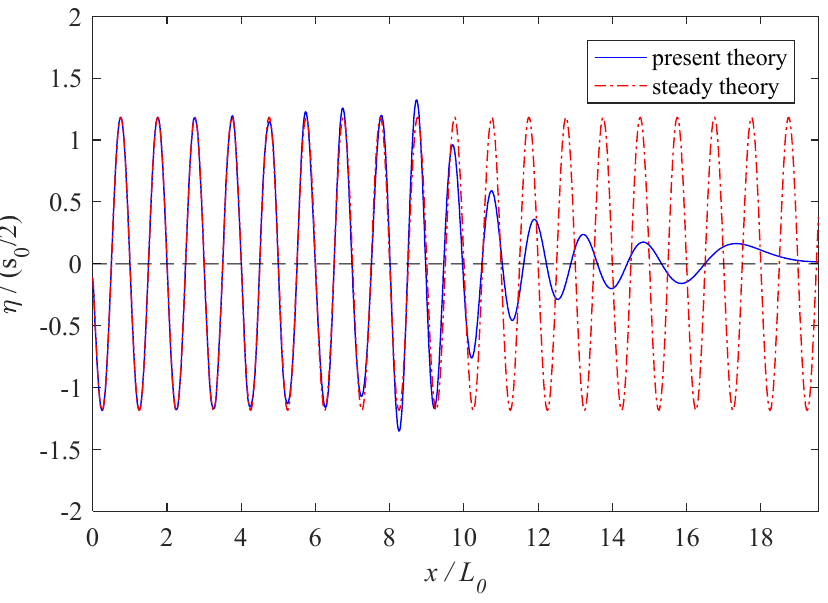
Figure 4. Wave elevations along the channel at t = 15 T .